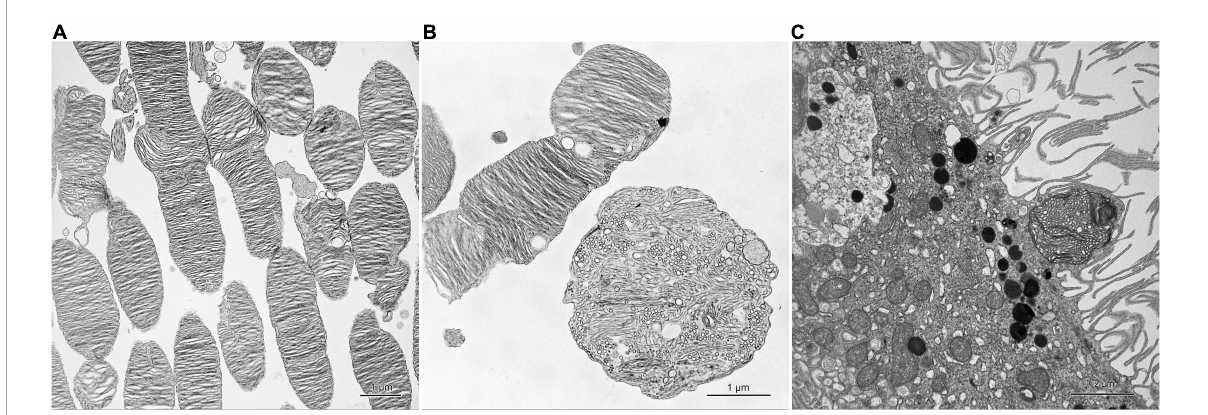
FIGURE2 Effect of monochromatic blue light exposure on the photoreceptor outer segments and retinal pigment epithelium morphology in Wistar rats. The rats were exposed to 12 h white light (150 lx) and 12 h darkness for 7 days (control, 32 rats), and 12 h blue light (150 lx) and 12 h darkness for 7 days (blue-light group, 32 rats). The figure presents retinal sample collected at 11:00. Ultrathin sections were visualized with transmission electron microscope (Tecnai, FEI). Photoreceptor outer segments display normal morphology in the control group (A) . In the blue-light group, these segments form round structures with vesicles and tubules (B) . Retinal pigment epithelium shows long and thin microvilli and ellipsoid structure trapped between them (C)